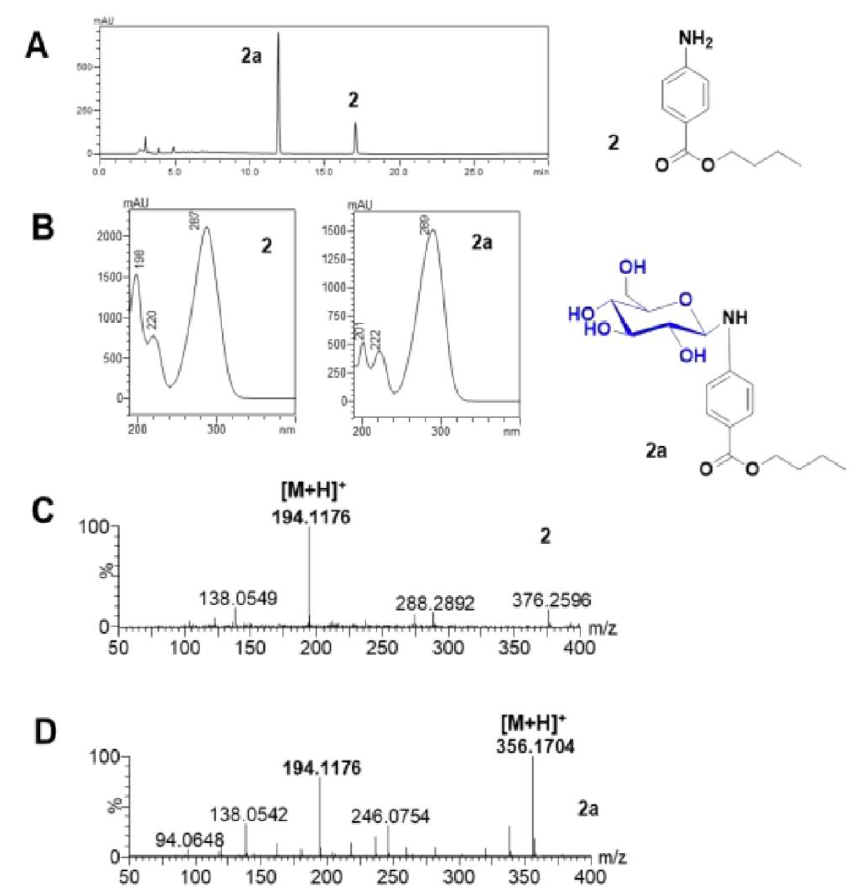
Figure 5. HPLC−PDA and HR−QTOF ESI/MS analysis conversion of butyl-4-aminobenzoate ( 2 ) as an aglycon acceptor of YdhE in C. glutamicum . ( A ) HPLC chromatogram; ( B ) UV spectra of 2 and glucosylated product 2a ; ( C ) Selected ion chromatogram at m/z 194.11 for substrate 2 [M+H] + ; and ( D ) Selected ion chromatogram at m/z 356.17 for glucosylated product of 2 [M+H] + .